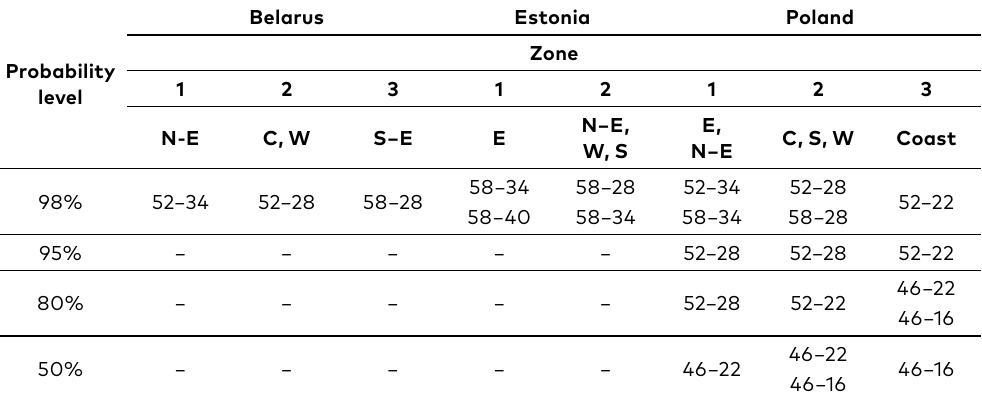
Table 1. Climatic zones by the Performance Grade system for wearing courses in Central Eastern European